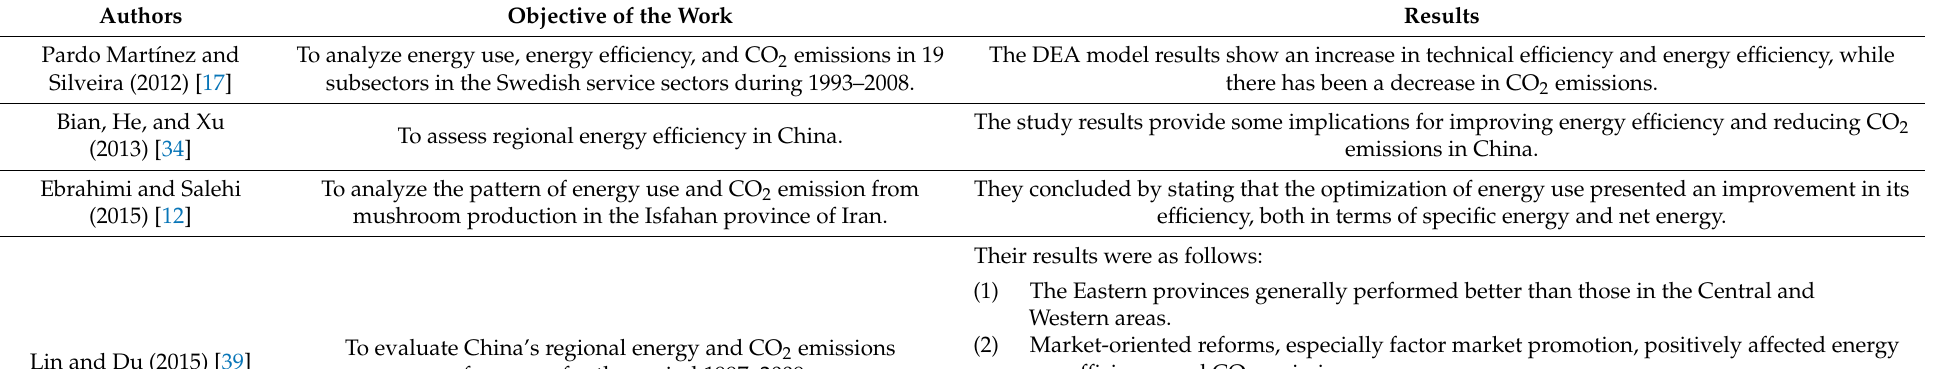
Table 1. Goals and results of the analyses carried out using the DEA